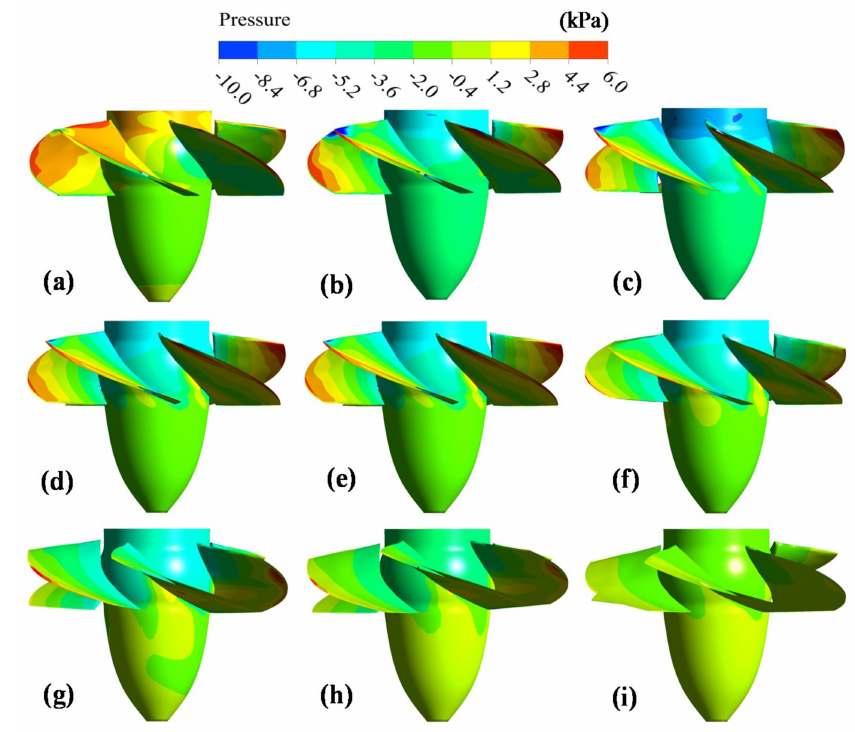
Figure 12. Distribution of the velocity vector and static pressure in the runner zone at different time: ( a ) t = 0 s, ( b ) t = 1.76 s, ( c ) t = 2.3 s, ( d ) t = 3.2 s, ( e ) t = 4.8 s, ( f ) t = 5.8 s, ( g ) t = 6.4 s, ( h ) t = 7.0 s, and ( i ) t = 9.2 s.